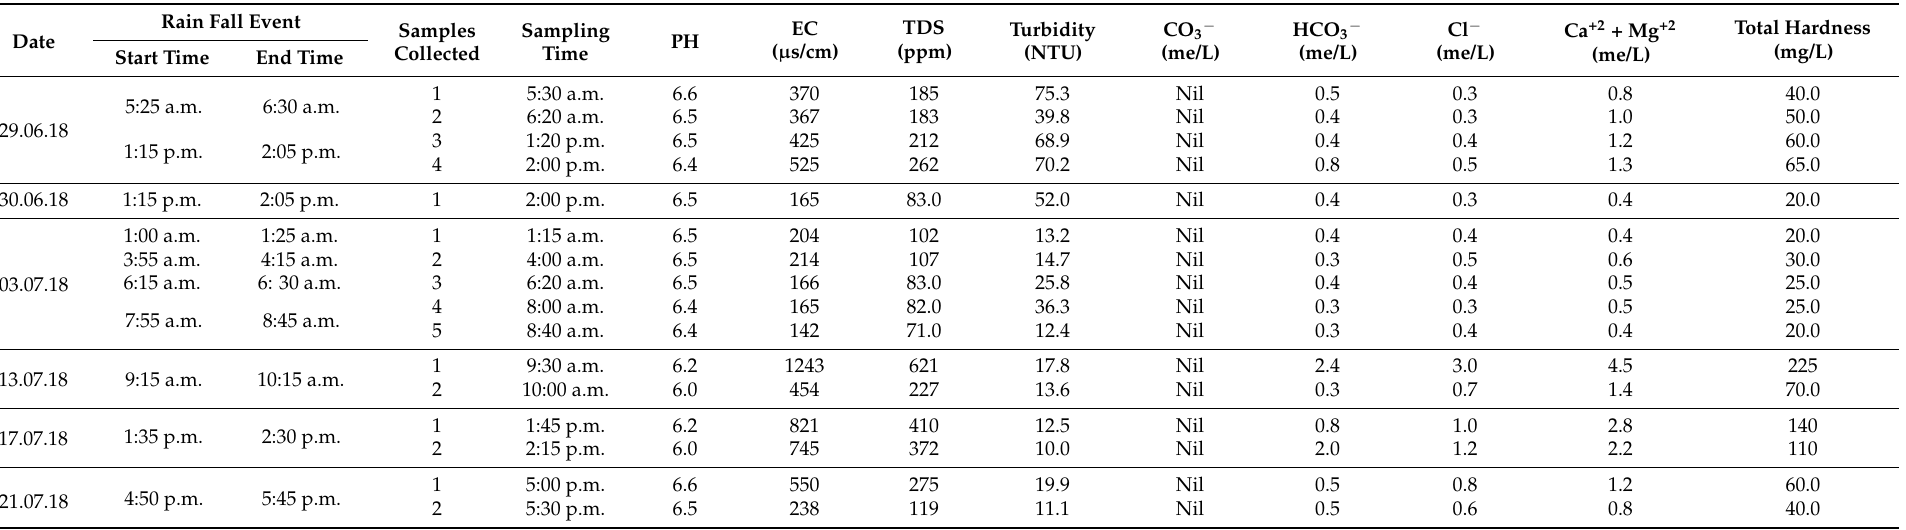
Table A12. Rain harvesting model samples collected from Site